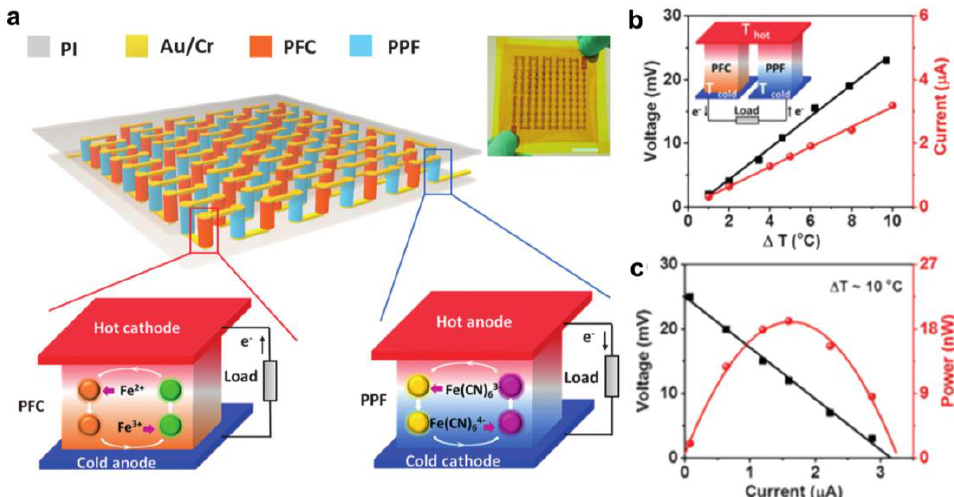
Figure 12. The integrated gel-based thermocell. Both the PFC and PPF gels were sandwiched between two flexible substrates (polyimide, PI). With alternating top and bottom interconnections, the PFC and PPF gels are connected sequentially in series. The magnified insets illustrate the operation mechanism of the gel-based thermocell. At a certain temperature difference, the thermo–voltage polarity of PFC and PPF is exactly reversed. The top right inset is a photograph of the integrated device (scale bar: 2 cm). (Reproduced with permission from [56]. Copyright 2016 WILEY-VCH Verlag GmbH & Co. KGaA, Weinheim).